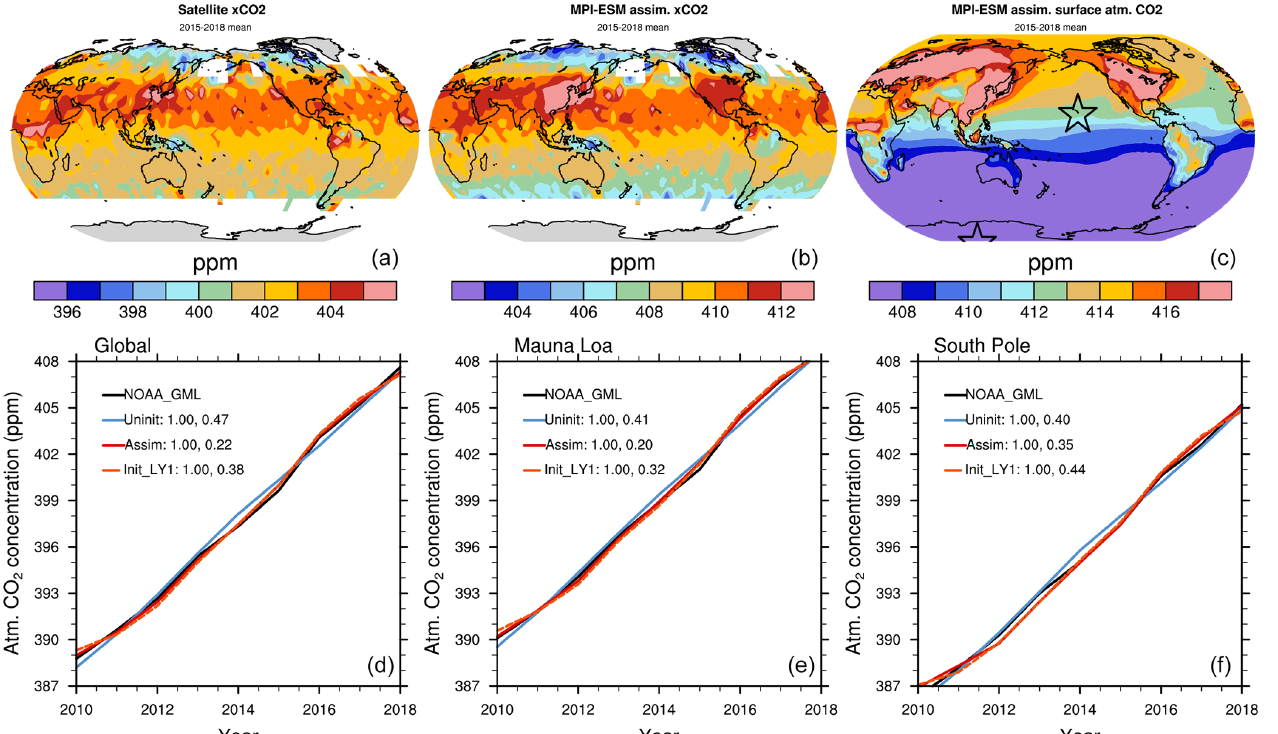
Figure 7. Spatial distribution of 2015–2018 mean satellite-based Obs4MIPs XCO 2 (a) , model assimilation of XCO 2 (resampled according to satellite data availability) (b) , and model assimilation of atmospheric CO 2 concentration at 1000hPa level (c) . A short time period of 2015– 2018 is used because of the limited temporal coverage of satellite data. The satellite XCO 2 data product is obtained from the Climate Data Store Copernicus Climate Change Service (Reuter et al., 2013). The conversion of model-simulated CO 2 to XCO 2 is performed according to Gier et al. (2020) (their Appendix A). Atmospheric CO 2 concentration as a global average (d) , at Mauna Loa (e) , and at the South Pole (f) from the uninitialized (Uninit) and assimilation (Assim) simulations and initialized simulations at a lead time of 1 year (Init_LY1) compared to observations over the 2010–2018 period. The locations of Mauna Loa and the South Pole are shown in (c) . The numbers in the legend show the correlation (left) and root-mean-square error (RMSE, right) of the simulations relative to observational data from NOAA_GML (Dlugokencky and Tans, 2020). The simulated time series from the MPI-ESM simulations, including uninitialized, assimilation, and initial- ized simulations, are bias corrected by removing the difference in mean states and the linear trend between observations and simulations according to Boer et al.